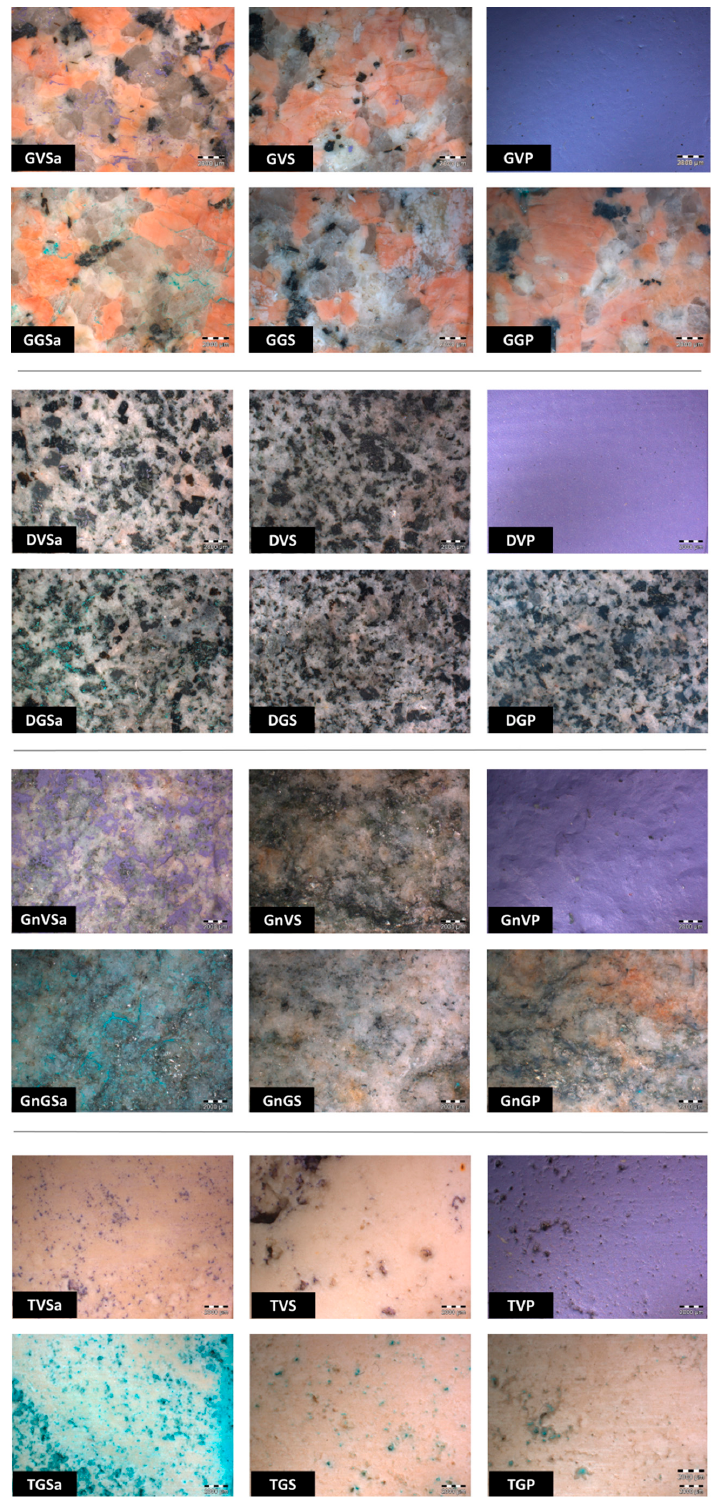
Figure 4. Micrographs taken by stereomicroscopy of the surfaces coated with anti-graffiti product after being cleaned with the products recommended by the manufacturers and the surfaces cleaned with the low-toxic ternary mixture. Check Table 1 for sample labeling.